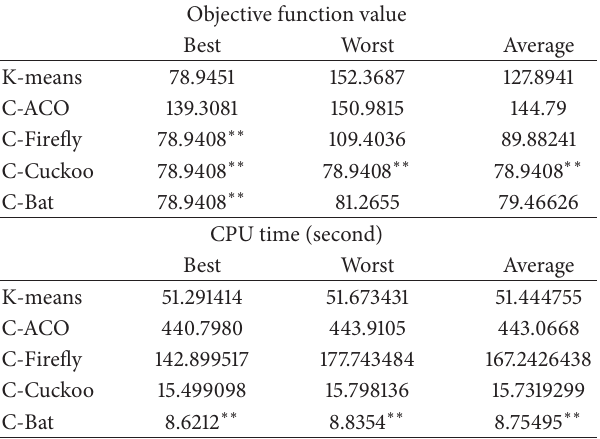
Table 7: Testing objective function fitness and CPU time consump- tion on